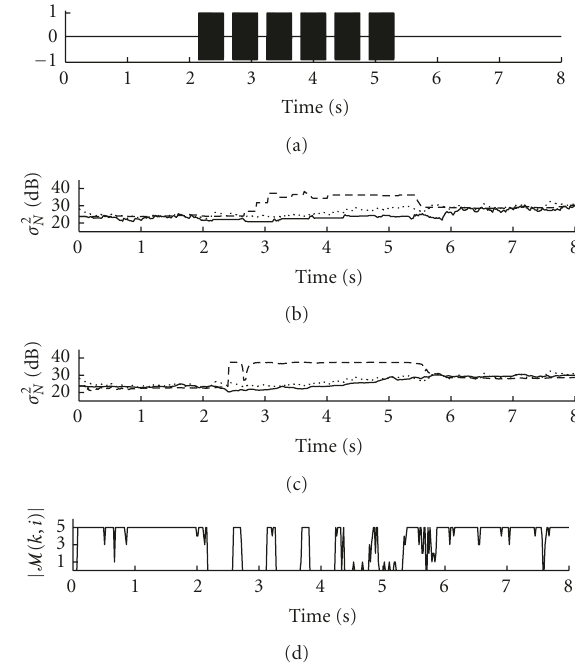
Figure 5: Synthetic noise tracking example with super-frame size of 40ms and P fa = 0 . 005. (a) Clean synthetic signal. (b) Comparison between true noise PSD (dotted line), proposed approach (solid line), and MS (dashed line) for DFT bin centered around 937.5 Hz. (c) Comparison between true noise PSD (dotted line), DFT- subspace approach (solid line), and QB approach (dashed line) for DFT bin centered around 937.5 Hz. (d) Cardinality of the set M ( k , i ) for the frequency bin centered around 937.5